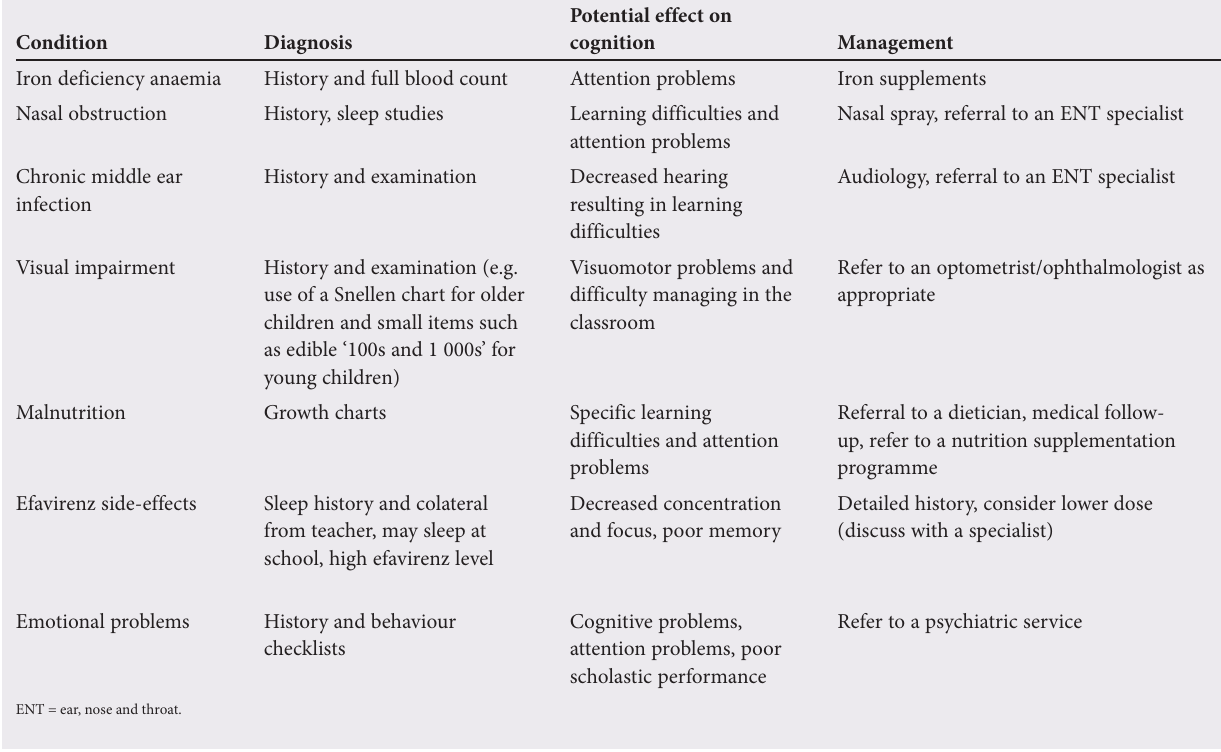
Table 15. Medical conditions that may affect cognition